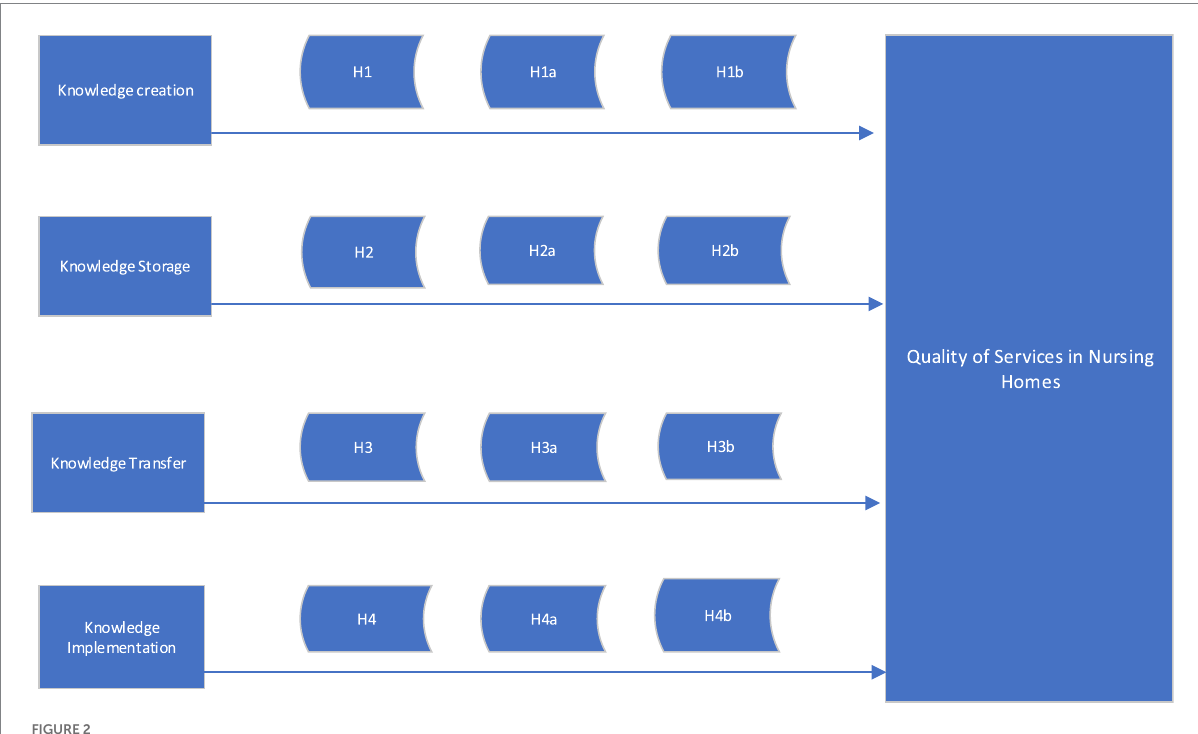
FIGURE 2 Within the conceptual model of relationships between knowledge creation, storage, transfer and implementation and quality of services in NH, we investigated whether there are differences between new knowledge creation, knowledge transfer, knowledge storage and knowledge implementation in two public nursing homes with a quality certificate E-Qalin and two private DEOS nursing homes with their own quality